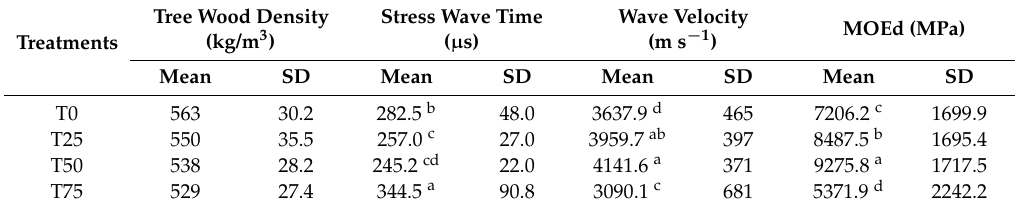
Table 2. Tree wood density, stress wave time, and mechanical properties for the sampled trees among the different treatments considered (SD: standard deviation; MOEd: dynamic modulus of elasticity). Means in the same column followed by the same letter are not statistically different at p ≤ 0.05 (Tukey test).